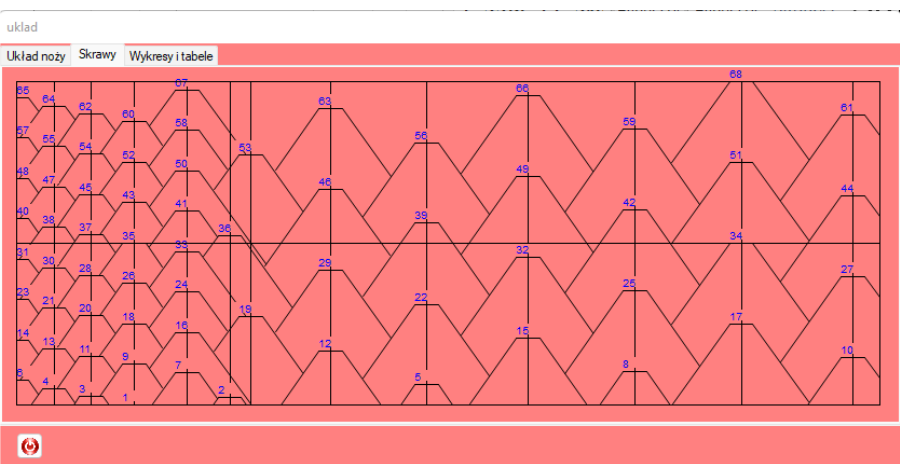
Figure 7. Arrangement of cuts for sample parameters.